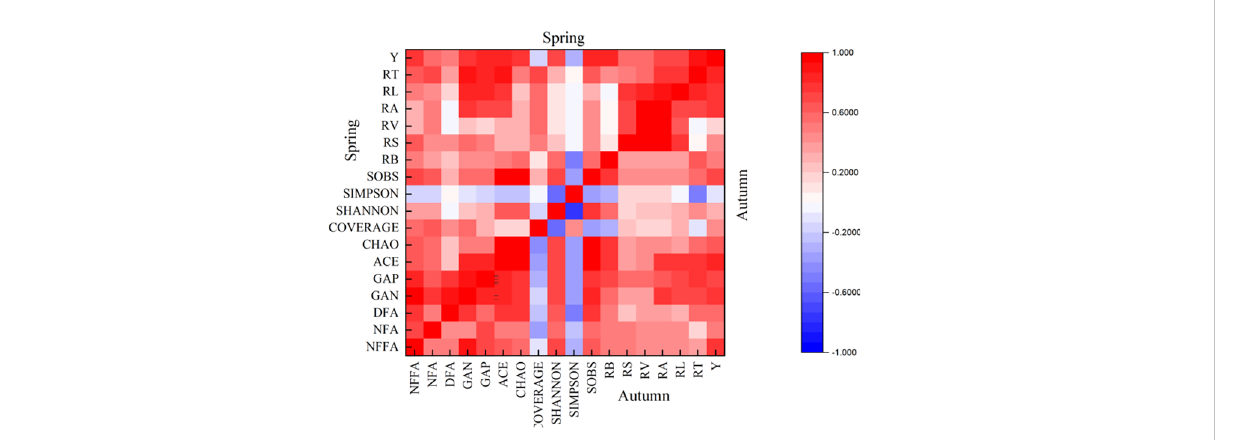
FIGURE 9 Correlation between tomato soil bacterial community, root system and yield. Spring represents the correlation between the indicators of spring tomato; Autumn represents the correlation between the indicators of autumn tomato. The NFFA represents the soil bacterial nitrogen fi xation functional gene abundance, the NFA represents the soil bacterial nitri fi cation functional gene abundance, the DFA represents the soil bacterial denitri fi cation functional gene abundance, the GAN represents the soil bacterial nitrogen metabolism functional gene abundance, GAP represents the soil bacterial phosphorus metabolism functional gene abundance. The ACE represents ACE index of soil bacterial, CHAO represents CHAO index of soil bacterial, COVERAGE represents COVERAGE index of soil bacterial, SHANNON represents SHANNON index of soil bacterial, SIMPSON represents SIMPSON index of soil bacterial, SOBS represents SOBS index of soil bacterial. The RL represents the total root length, the RS represents the total root surface area, the RV represents the total root volume, the RT represents the total number of root tips, the RB represents the total root bifurcation number, the RA represents the root activity. The Y represents the